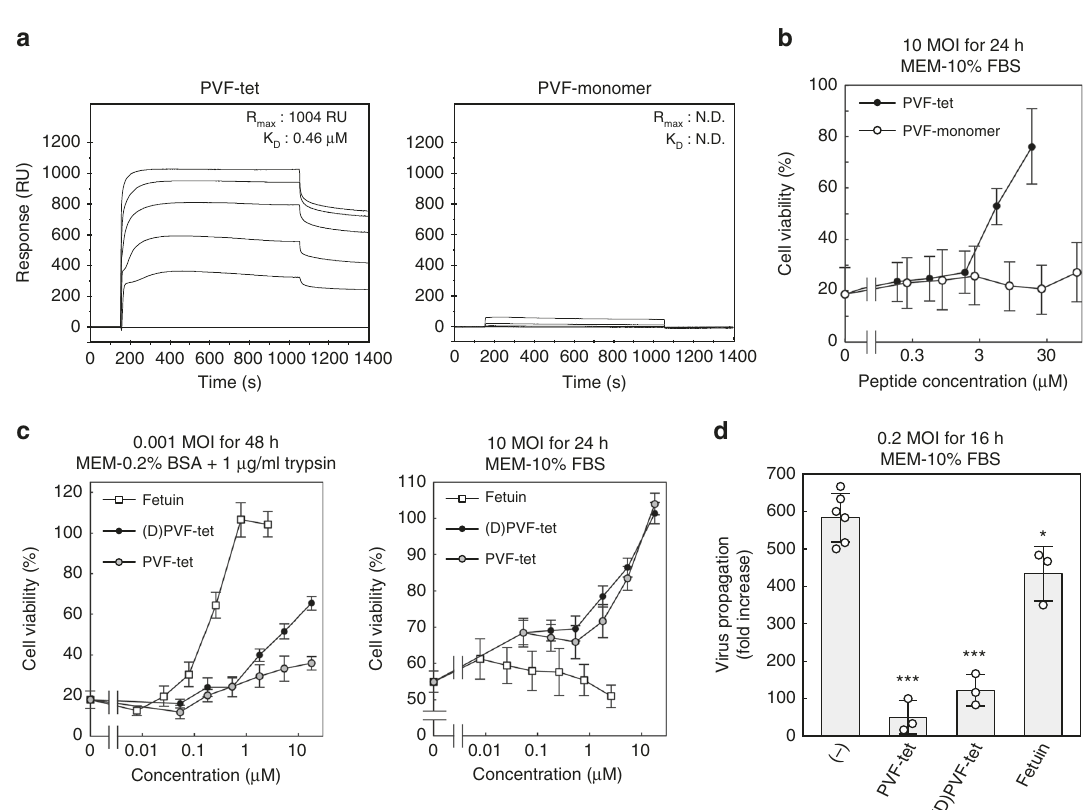
Fig. 2 PVF-tet functions based on the clustering effect, especially under a high MOI. a Kinetics of the binding of PVF-tet or its monomer peptide to immobilized HA analyzed using the BIAcore system. The resonance unit (RU) is an arbitrary unit used by the BIAcore system to indicate peptide binding. b The effects of PVF-tet or its monomer peptide on the cytopathicity induced by IAV infection. MDCK cells were incubated with the indicated concentrations of each compound for 30 min, and then infected with IAV strain PR8 at 10 MOI for 24 h in the presence of the indicated amounts of each peptide. Data are presented as a percentage of the control value without infection (mean ± SEM of three independent experiments). c The effects of fetuin or each tetravalent peptide on the cytopathicity induced by IAV infection. MDCK cells were incubated with the indicated concentrations of each compound for 30 min, and then infected with IAV strain PR8 at 0.001 MOI in the presence of 1 μ g/ml trypsin for 48 h (left panel) or 10 MOI in the absence of trypsin for 24 h (right panel). Data are presented as a percentage of the control value without infection (mean ± SEM of three independent experiments). d The effect of fetuin (7.8 μ M ) or each tetravalent peptide (60 μ M ) on virus propagation after IAV infection. MDCK cells were incubated with the indicated concentrations of each compound for 30 min, and then infected with IAV strain PR8 at 0.2 MOI for 16 h. The virus titer in the supernatant was determined by a plaque assay. Data are presented as a fold increase over the initial virus titer (60,000 pfu/ml) (mean ± SD of 3 – 6 independent experiments). * P < 0.05; *** P < 0.001 (compared with no compound ( − ) treatment by ANOVA followed by one-sided Dunnett ’ s test). Experimental details are shown above each panel. Source data are provided as a Source Data fi